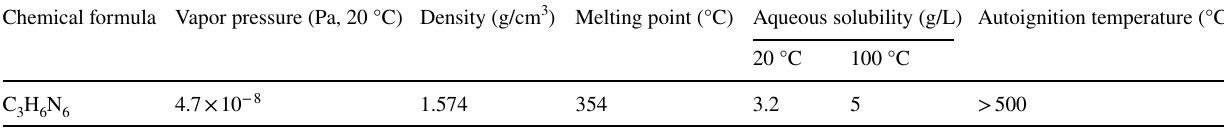
Table 1 The chemical and physical properties of